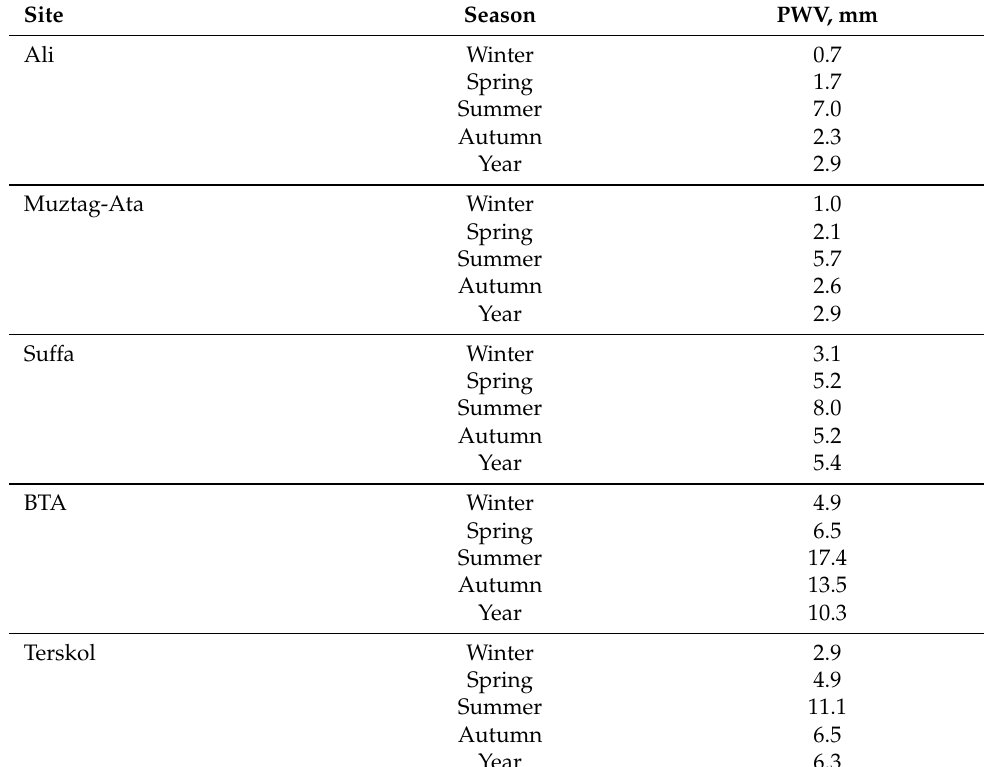
Table 8. Mean values of PWV at the sites suitable for mm/submm